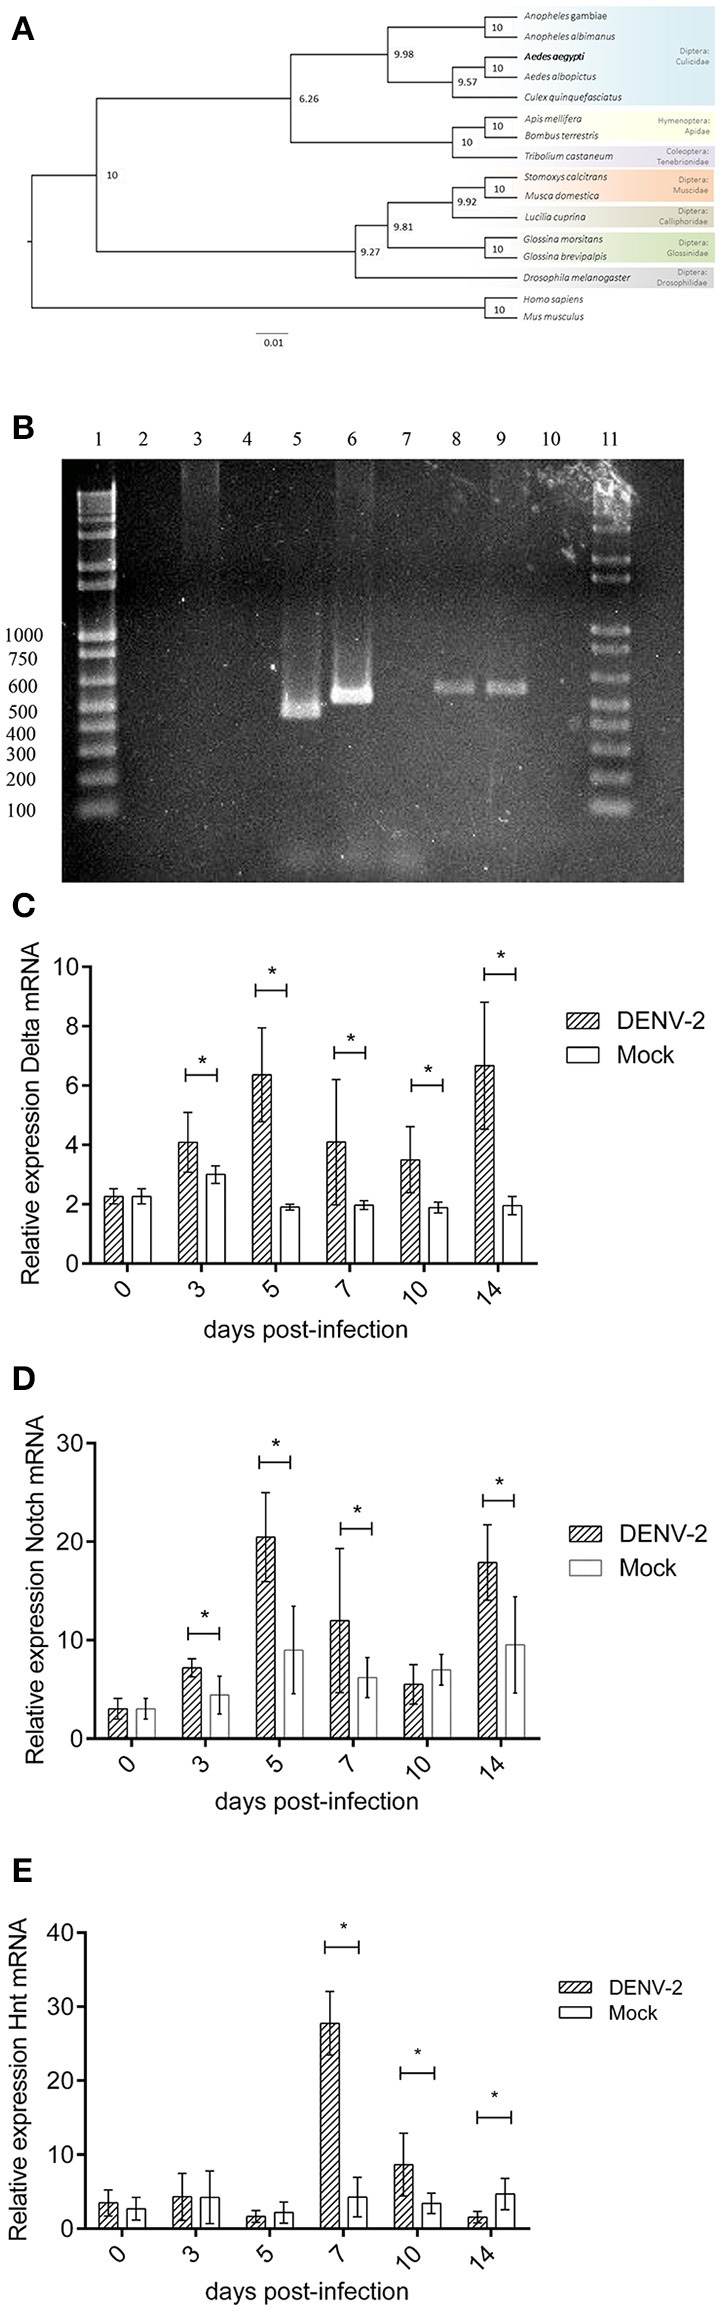
(A) Notch pathway transcriptional analysis during DENV infection in Aedes aegypti midguts. Hindsight and RREB-1 phylogenetic tree based on maximum-likelihood algorithm. The sequences shown were aligned using MUSCLE tool. The phylogenetic tree was constructed using PhyML software v3.0 with 1,000 bootstrap sample repetitions. (B) Notch pathway transcriptional analysis during DENV infection in Aedes aegypti midguts. Hindsight PCR from mosquito midguts gDNA and cDNA. Lanes, (1) 3 Kb Ladder. (2) cDNA (mRNA)–Hnt A amplicon. (3). gDNA–Hnt A amplicon. (4) No template control–Hnt A amplicon. (5) cDNA (mRNA)–Hnt B amplicon. (6) gDNA–Hnt B amplicon. (7) No template control–Hnt B amplicon. (8) cDNA (mRNA)–Hnt C amplicon. (9) gDNA–Hnt C amplicon. (10) No template control–Hnt C amplicon. (11) 3 Kb Ladder. (C) Notch pathway transcriptional analysis during DENV infection in Aedes aegypti midguts. Relative expression of Delta transcript 0, 3, 5, 7, 10, and 14 days post alimentation with blood (Mock) or blood with 1 × 108 DENV2 FFU/mL (DENV-2). Mock vs. DENV-2 Student's T-test with Welch's correction 0, 3, 5, 7, 10, 14 dpi t = 0.0, 3.58, 9.74, 3.47, 4.93, and 7.55, p > 0.9999, 0.0055, <0.0001, 0.0082, 0.0010, <0.0001. (D) Notch pathway transcriptional analysis during DENV infection in Aedes aegypti midguts. Relative expression of Notch transcript 0, 3, 5, 7, 10, and 14 days post alimentation with blood (Mock) or blood with 1 × 108 DENV2 FFU/mL (DENV-2). Mock vs. DENV-2 Student's T-test with Welch's correction 0, 3, 5, 7, 10, 14 dpi t = 0.0, 4.51, 6.25, 2.63, 2.04, 4.66, p > 0.9999, 0.0008, <0.0001, 0.0267, 0.0592, 0.0003. (E) Notch pathway transcriptional analysis during DENV infection in Aedes aegypti midguts. Relative expression of Hindsight transcript 0, 3, 5, 7, 10, and 14 days post alimentation with blood (Mock) or blood with 1 × 108 DENV2 FFU/mL (DENV-2). Mock vs. DENV-2 Student's T-test with Welch's correction 0, 3, 5, 7, 10, and 14 dpi t = 1.18, 0.29, 1.03, 16.04, 4.06, 4.77, p = 0.2539, 0.7749, 0.3191, <0.0001, 0.0024, 0.0007.